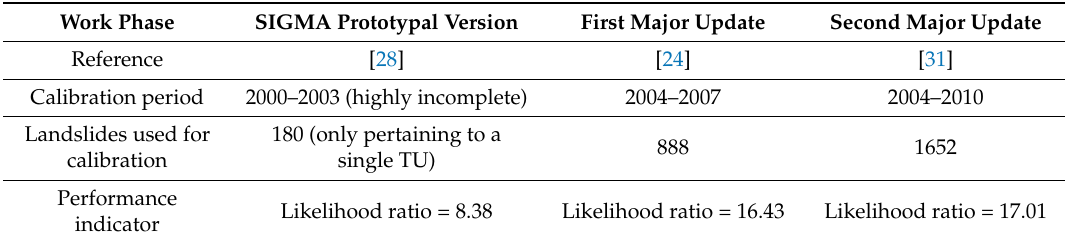
Documented increase of the forecasting effectiveness of SIGMA by expanding the calibration